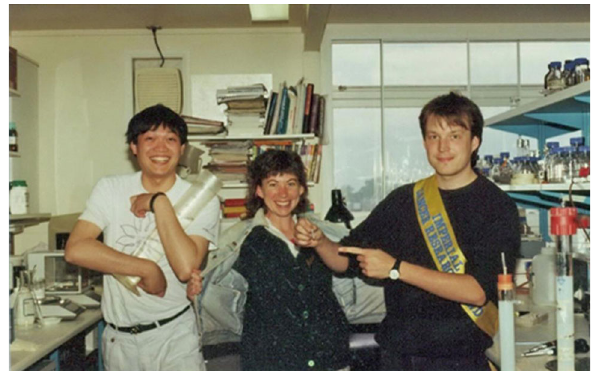
Figure 3. Dr. Jian Zhou (left) at the Tumor Virus Laboratory of Cambridge